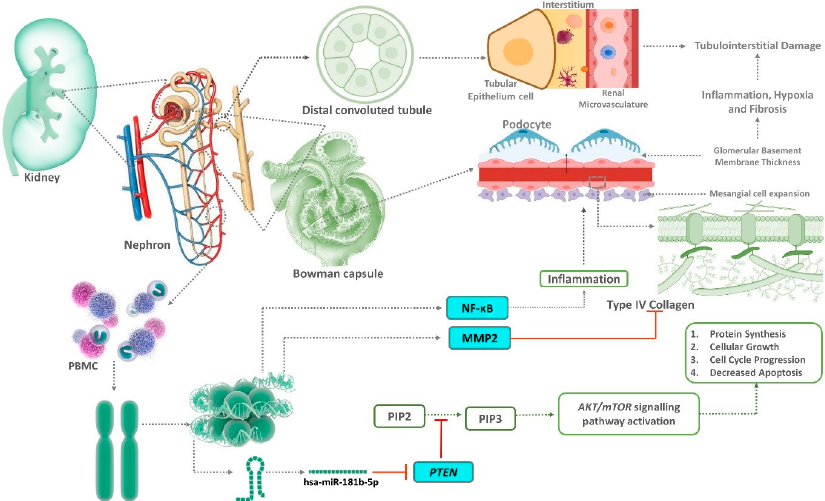
Figure 7. Role of circulating PTEN, MMP2, and NF- ĸ B as well as their target microRNA-181b in renal fibrosis via the AKT/mTOR signalling pathway during aggravation of diabetic nephropathy. PTEN antagonizes the PI3-kinase/AKT pathway by reconverting phosphatidylinositol 3,4,5-triphosphate (PIP3) back to phosphatidylinositol 3,4-bisphosphate (PIP2). The activation of mammalian target of rapamycin (mTOR) is responsible for diabetic nephropathy. Hyperglycaemia stimulates phosphatidylinositol-3 kinase (PI3K) and protein kinase B(AKT) pathways, which subsequently activates mTOR. Downregulated MMP2 and activated mTOR is responsible for basement membrane thickening, mesangial matrix expansion, and renal fibrosis. NF- ĸ B caused an inflammatory response with the progression of the disease.